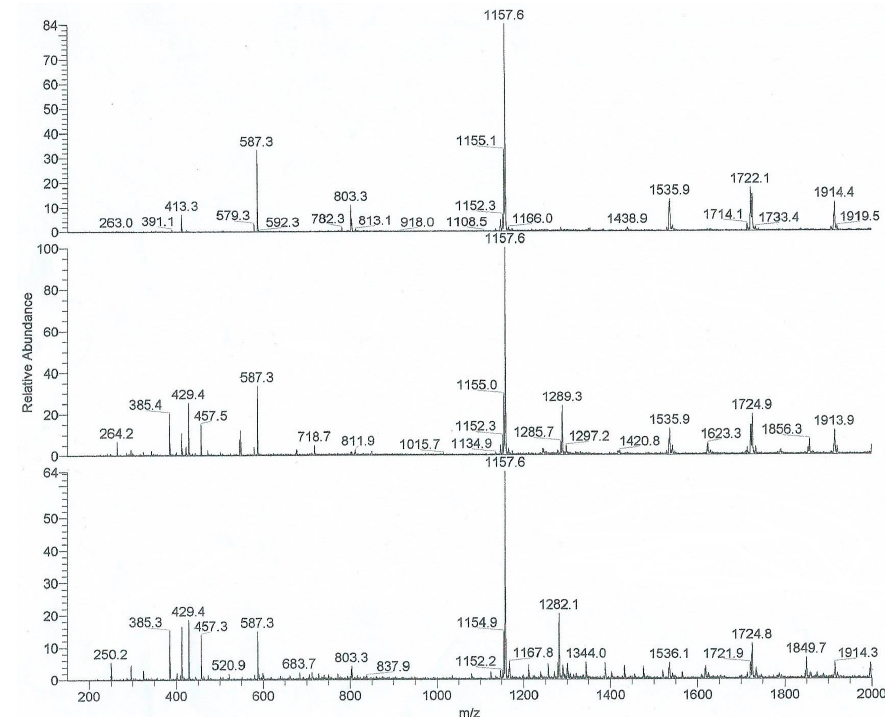
Figure 2. ESI-MS spectra of 2-[( p -methyl-phenyl)amine]-1,4-naphthalenedione and β -CD. Upper spectrum : β -CD control: MNa + ion at m / z 1157.6. Middle spectrum : β -CD (2 × 10 − 5 M) complexed with PAN 10 (2 × 10 − 6 M), ratio 10:1; 2 β -CD + PAN 10 ion at m / z 1289.2 (MNa 2 ) 2+ ; PAN 10 MH + ion at m / z 264.2; β -CD MNa + ion at m / z 1157.6. Bottom Spectrum : β -CD (2 × 10 − 5 M) complex with PAN 1 (2 × 10 − 6 M), ratio 10:1; 2 β -CD + PAN 1 ion at m / z 1282.1 (MNa 2 ) 2+ ; PAN 1 MH + ion at m / z 250.2; β -CD MNa + ion at m / z 1157.6. When the MS/MS experiments were performed on (CD 2 MNa 2 ) 2+ ion formation of daughter ions at (CDMNa) + and (CD 2 MH) + were not observed; the only daughter ions recorded were (CDNa) + and MH +